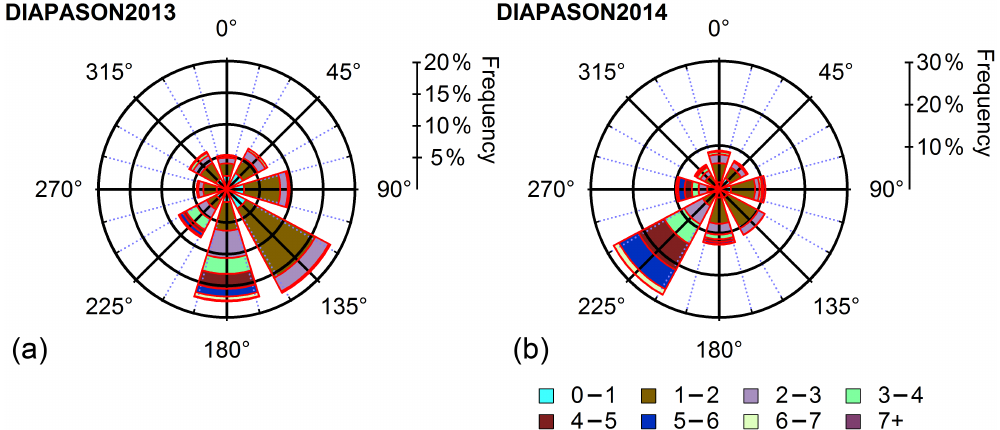
Figure 1. Relative frequency of local wind directions (in ◦ ) colour coded with wind speed measured during DIAPASON2013 (left) and DIAPASON2014